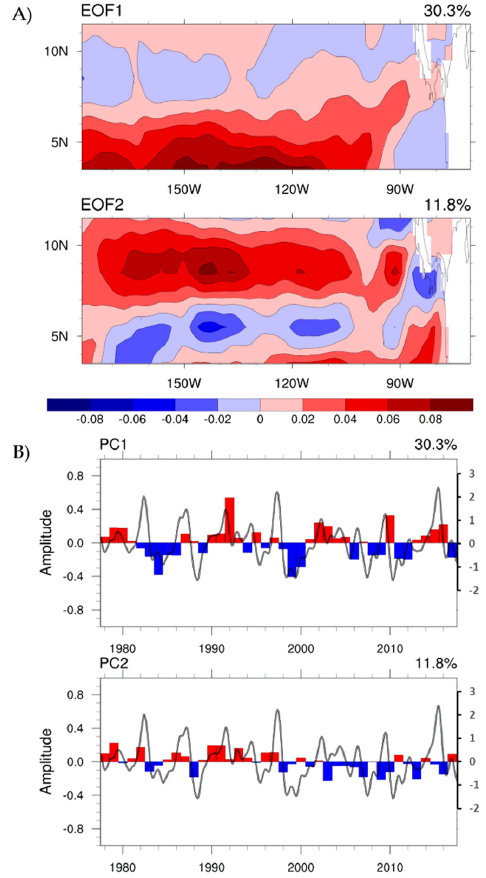
Figure 4. same as Figure 2, but for winter (DJF): ( A ) spatial pattern and ( B ) time series of the principal component superimposed with 6 months low-pass filtered NIÑO 3.4 index. Red and blue bars represented the NECC’s strengthening and weakening, respectively.